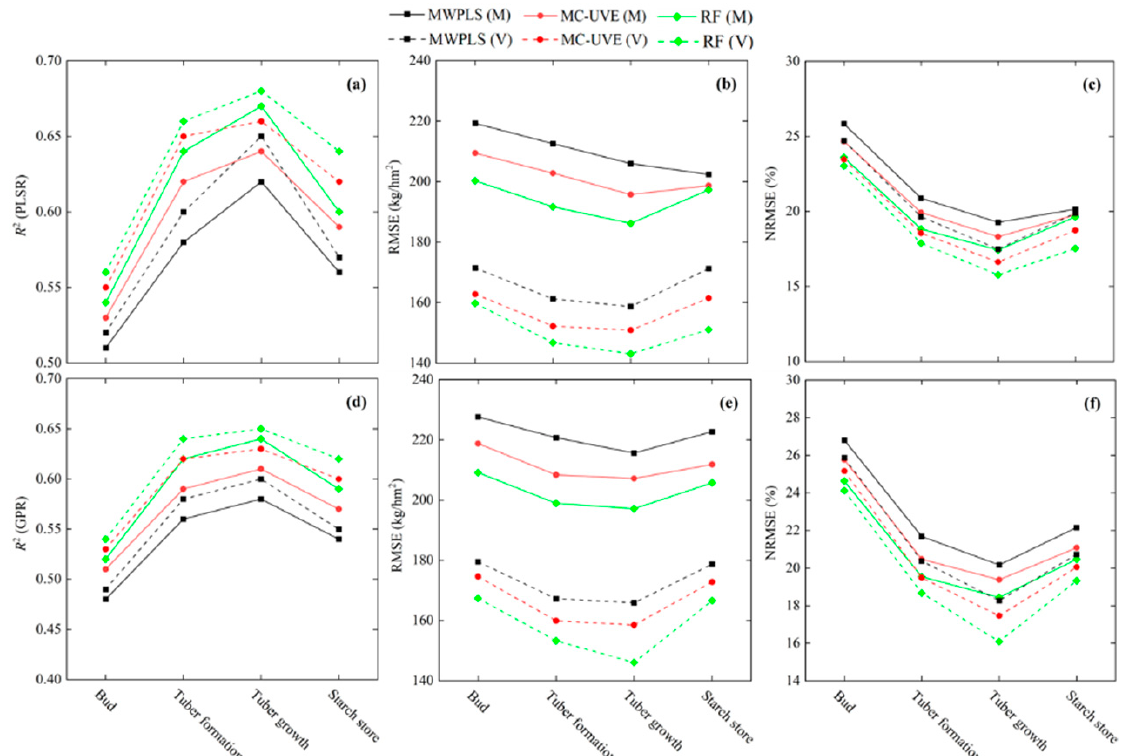
Figure 12. Accuracy of estimating AGB based on the feature variables screened from vegetation indexes by MWPLS, MC-UVE and RF. ( a – c ) The R 2 , RMSE (kg/hm 2 ) and NRMSE (%) of AGB was estimated using the PLSR method. ( d – f ) The R 2 , RMSE (kg/hm 2 ) and NRMSE (%) of AGB was estimated using the GPR